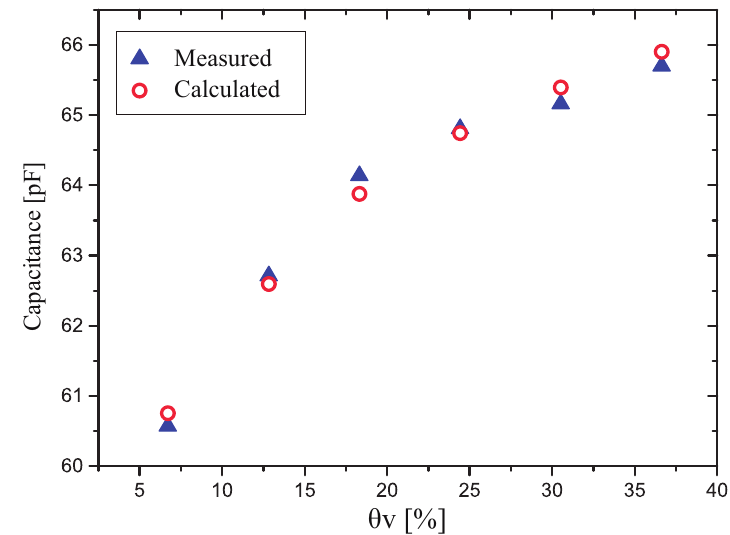
Figure 10. Comparison of the measured capacitance with the calculated capacitance (as a function of θ v ) of a sensor with two series capacitors, one with a constant value (75 pF) and one varying linearly with θ v , from 460 pF to 1126